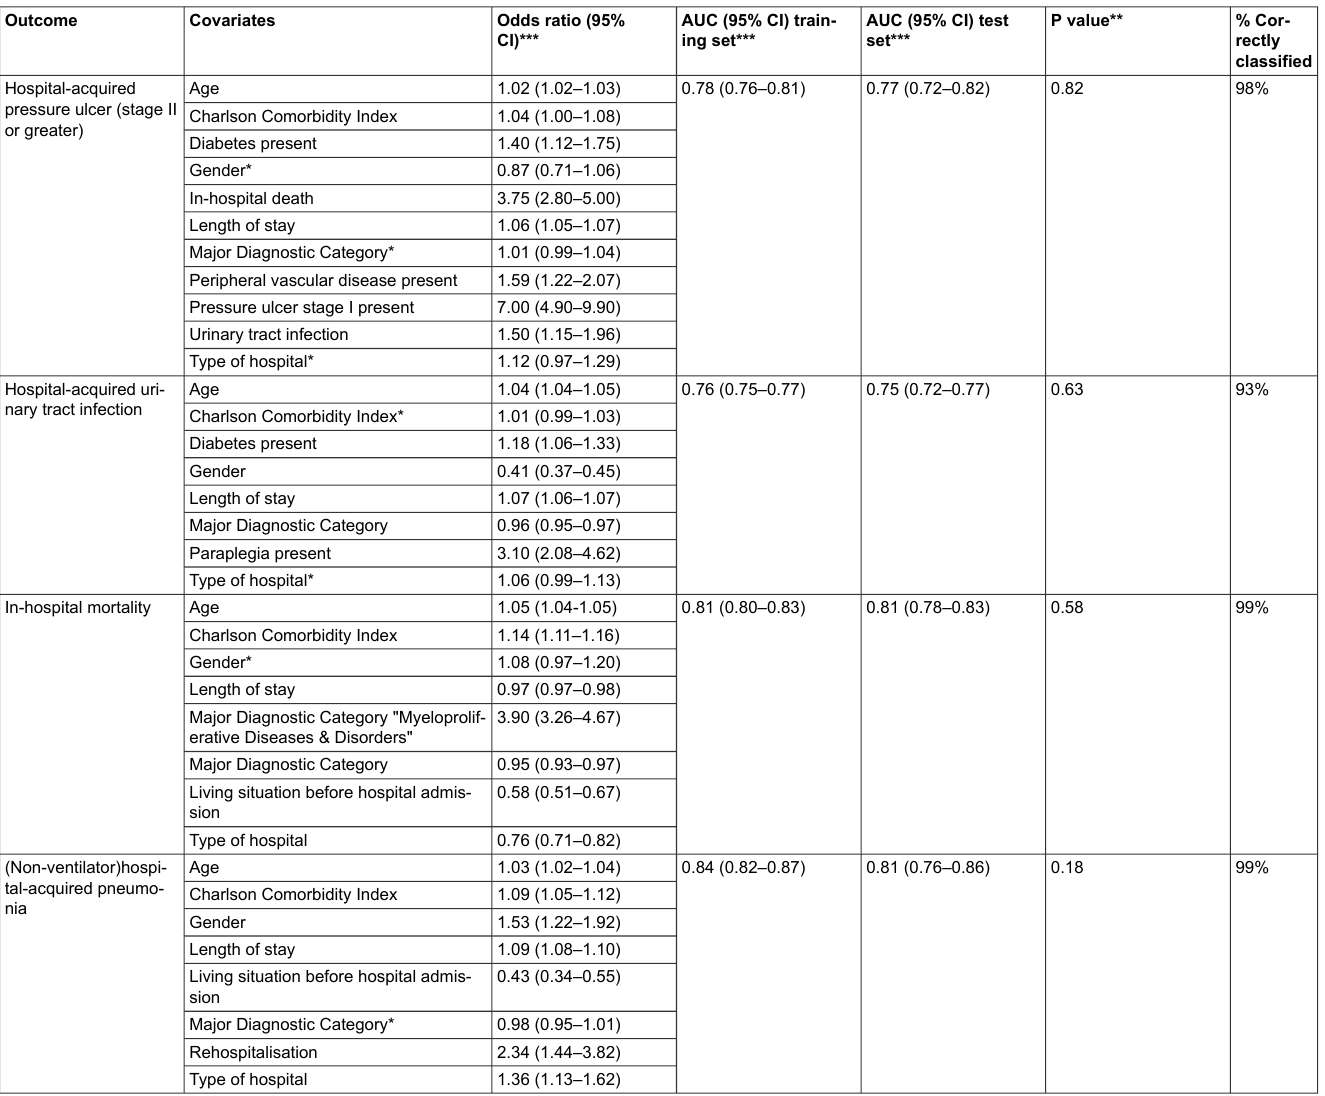
Table 3: Adjustment model per nursing-sensitive outcome.